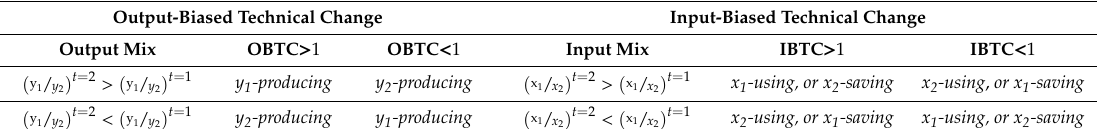
Table 2. Identifying criteria for biased technical change.